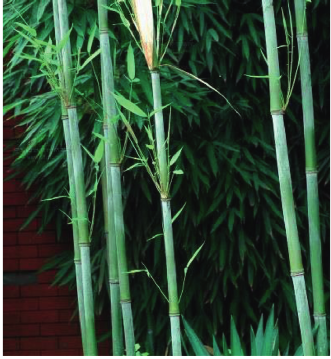
Figure 4: Neosinocalamus affinis